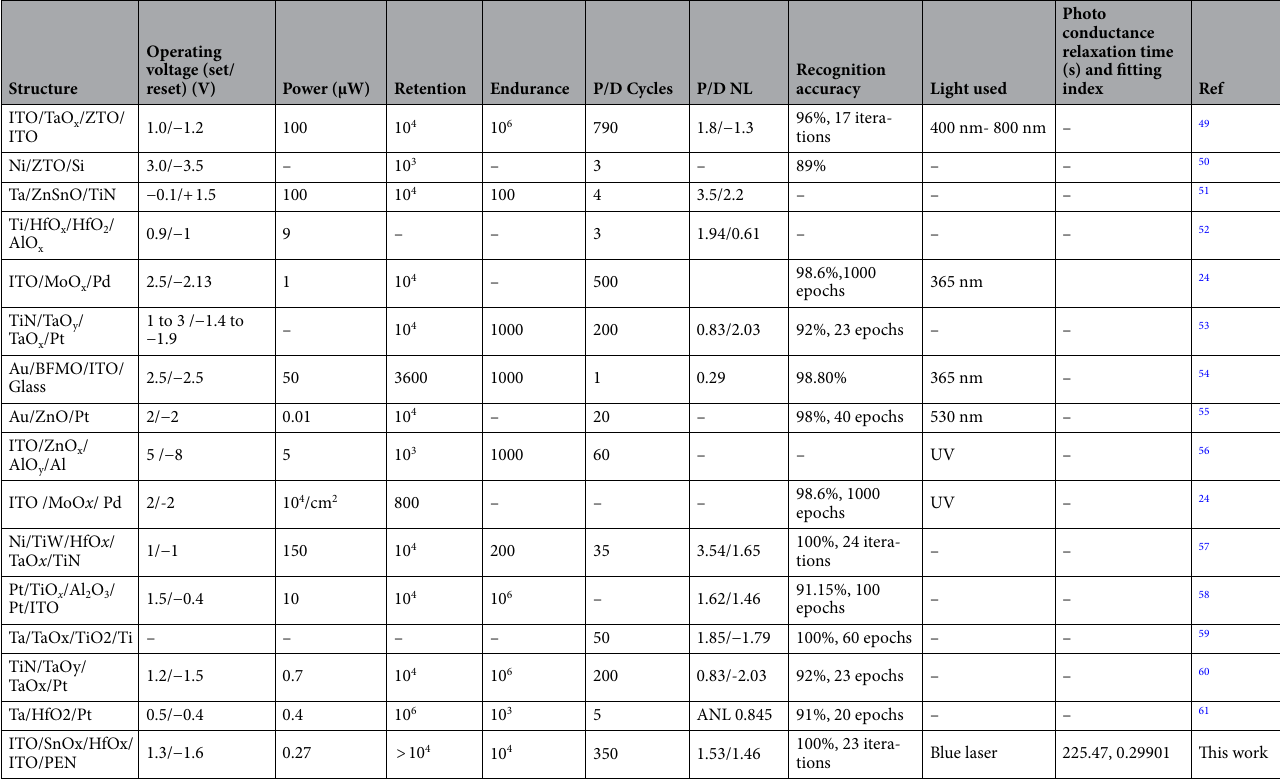
Table 3. Comparison of different resistive switching parameters of our results with the reported